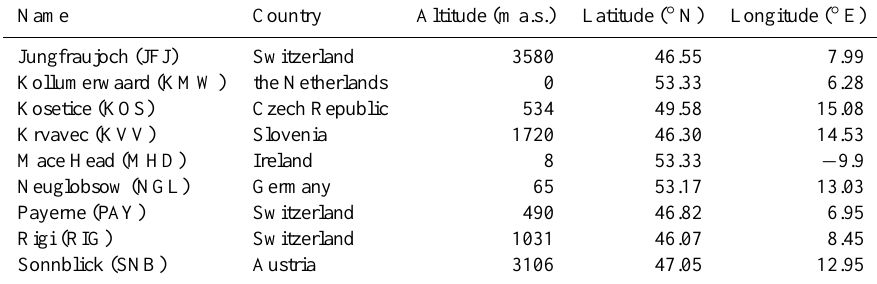
Table 1. The names and abbreviations of ground measurement stations used in the evaluation of O 3 and CO in MATCH. Name Country Altitude